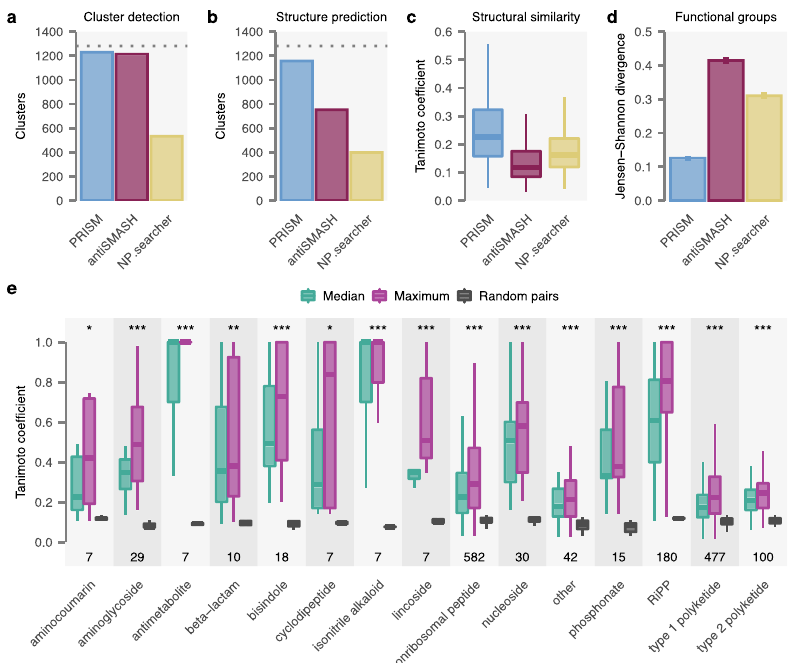
Fig. 2 PRISM 4 generates highly accurate chemical structure predictions. a Number of BGCs within a manually curated gold standard set ( n = 1,281; dotted line) identi fi ed by PRISM 4, antiSMASH 5, and NP.searcher. b Number of BGCs within the gold standard set with at least one structure predicted by each program. c Median Tanimoto coef fi cient between true and predicted structures for the subset of gold standard BGCs with at least one predicted structure generated by all four programs ( n = 385). d Jensen – Shannon divergence between functional group content of true and predicted structures for each program. Errors bars show standard deviation of bootstrap resampling. e Median and maximum Tanimoto coef fi cients between true and predicted structures generated by PRISM 4 for the gold standard set, by biosynthetic family, and compared to the median Tanimoto coef fi cient between predicted structures and non-matched BGCs ( “ random pairs ” ). Top, statistical signi fi cance of the comparison between median and random Tanimoto coef fi cients (*** p < 0.001; ** p < 0.01; * p < 0.05, two-sided t -test). Bottom, number of BGCs from each family in the gold standard set (n). Box plots show median (horizontal line), interquartile range (hinges), and the smallest and largest values no more than 1.5 times the interquartile range (whiskers) throughout. Source data are provided as a Source Data fi